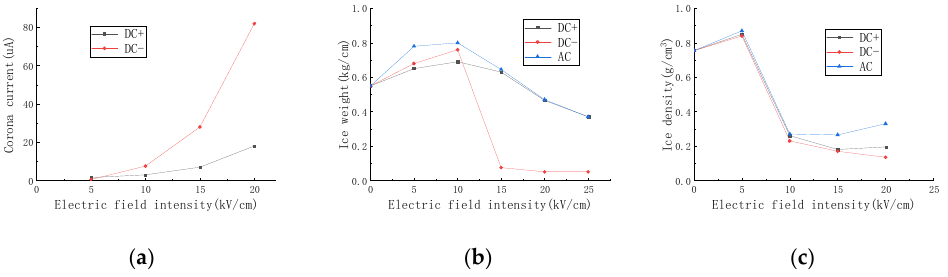
Figure 7. Relation between corona current, ice weight, ice density and electric field intensity. ( a ) Relation between corona current and electric field intensity. ( b ) Relationship between icing accretion and the electric field intensity. ( c ) Relation between ice density and electric field intensity.